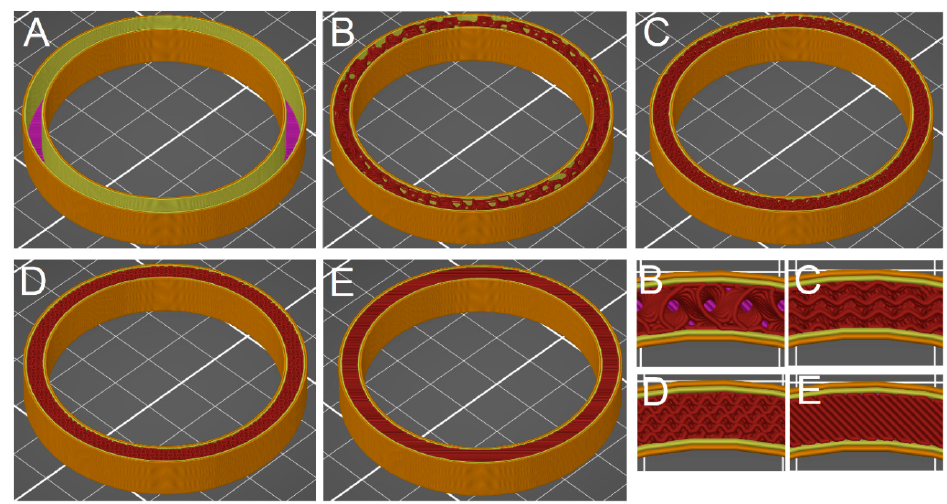
Figure 1. A diagram of the structures of the prepared samples: ( A )—0% filling density, ( B )—20% filling density, ( C )—50% filling density, ( D )—80% filling density, ( E )—100% filling density. The details of the respective individual types of filling are shown at the bottom right (labeled according to the specific sample). Table 1. Summarization of printing processes for all produced samples.